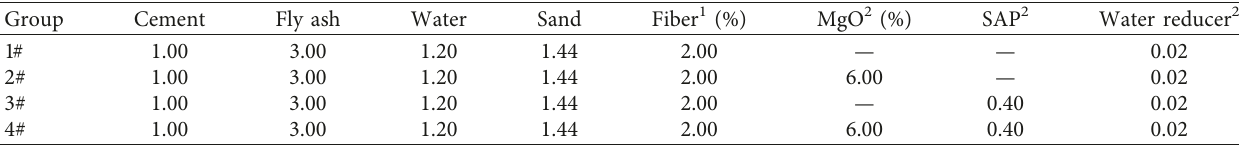
Table 5: Mix proportions (weight ratio).